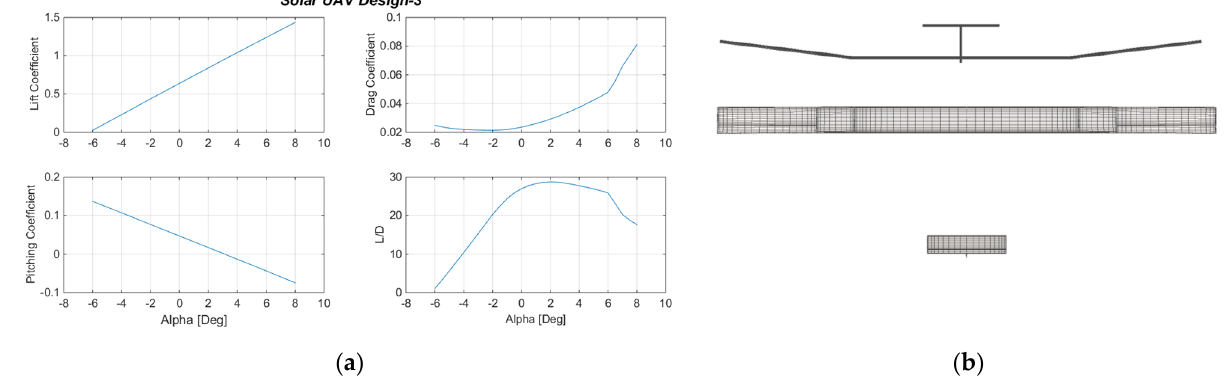
Figure 8. ( a ) Lift, drag, moment, and L/D of Design-3, ( b ) Xflr5 model.